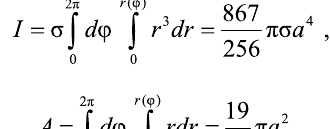
tion of b (Figure 4). The critical values of the parameter b correspond to the onset of rotations of 180 ◦ / k angles per scan line. Beyond these critical values the angular velocity remains almost constant and the function θ ( b ) slightly increases (Figure 3). When k = 3 and 4 two further critical values of b are found ( b = 0.9 and 0.35 respectively), corresponding to rota- tions of 2 × 180 ◦ / k angles per scan line. On the other hand, when b is small enough, the angular velocity d Φ / dN becomes negligible: Rather than rotating, the islands simply ‘wobble’ like the